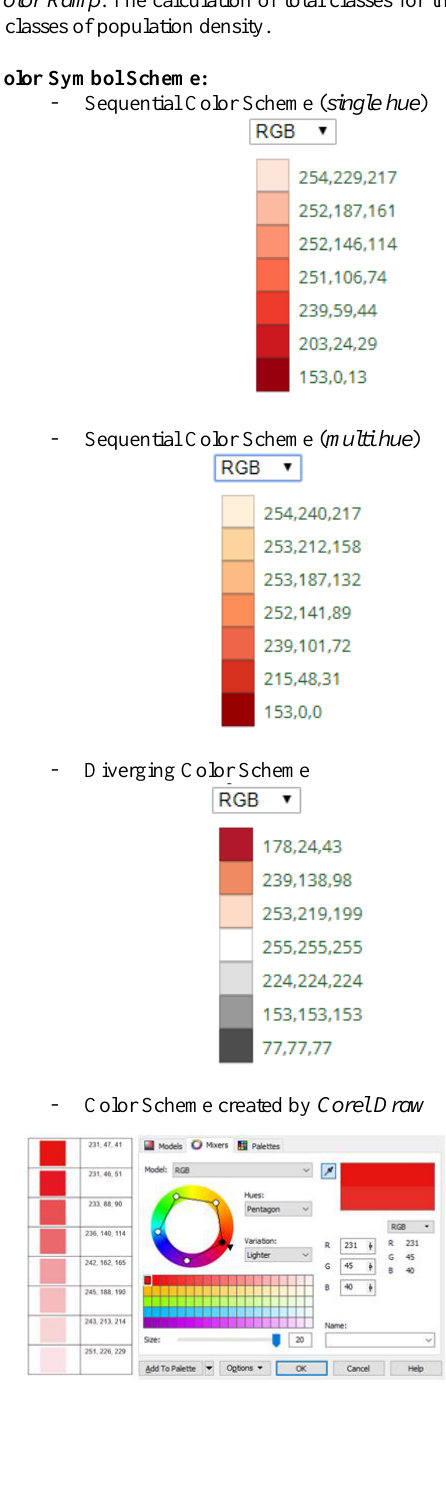
Color symbol scheme is a color symbol generator